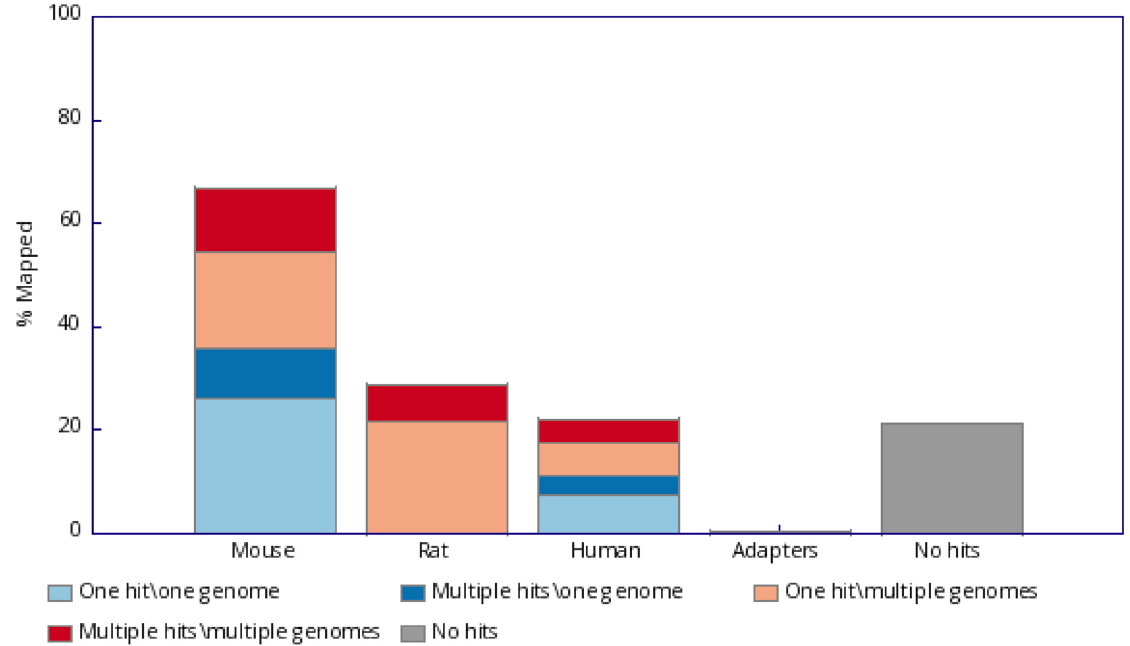
Figure 1. Graphical output from FastQ Screen after mapping a publicly available RNA-Seq sample (SRR5100711) against several reference genomes. Reads either i) mapped uniquely to one genome only (light blue), ii) multi-mapped to one genome only (dark blue), iii) mapped uniquely to a given genome and mapped to at least one other genome (light red), or iv) multi-mapped to a given genome and mapped to at least one other genome (dark red). The reads represented by blue shading are significant since these are sequences that align only to one genome, and consequently, if are observed in an unexpected genome they suggest